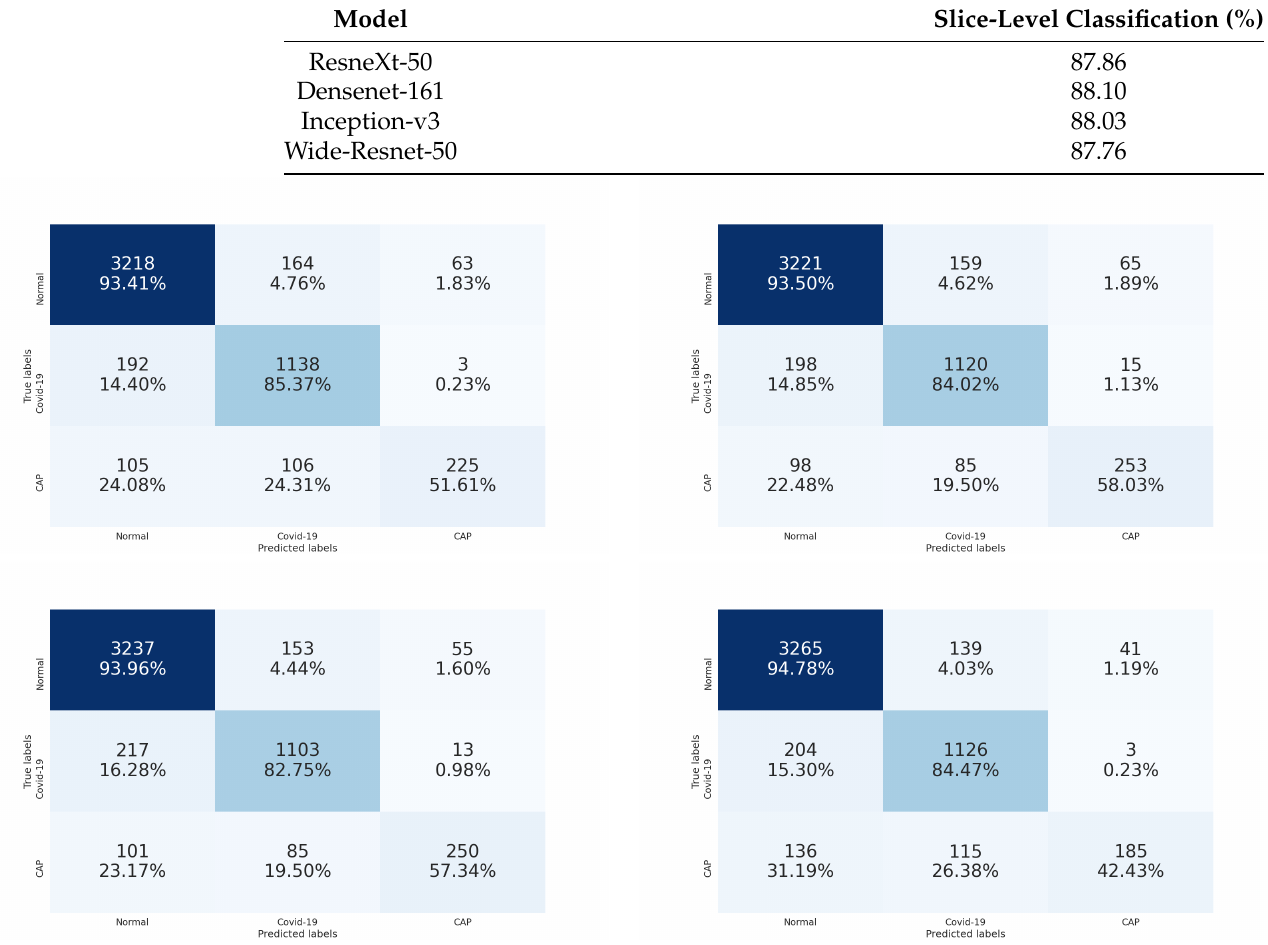
Figure 7. Confusion matrices of the stacked grayscale image and the segmented lung lobes on validation data using ResneXt-50, Densenet-161, Inception-v3, and Wide-Resnet-50, respectively. The vertical axis is for the true classes, and the horizontal axis is for the predicted